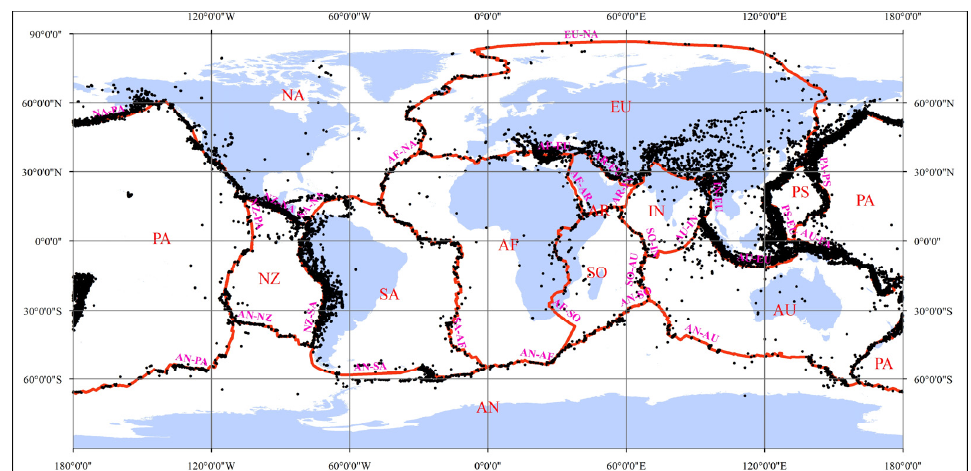
Figure 2. Map of world’s earthquake events and plate boundaries. Black dots are earthquakes with magnitudes greater than 5.6, the red text gives the names of plates (AF: Africa, AN: Antarctica, SO: Somalia, IN: India, AU: Australia, NZ: Nazca, EU: Eurasia, PA: Pacific, SA: South America, PS: Philippine Sea, NA: North America, AR: Arabia), red lines show plate boundaries, and purple text gives the names of plate boundaries .